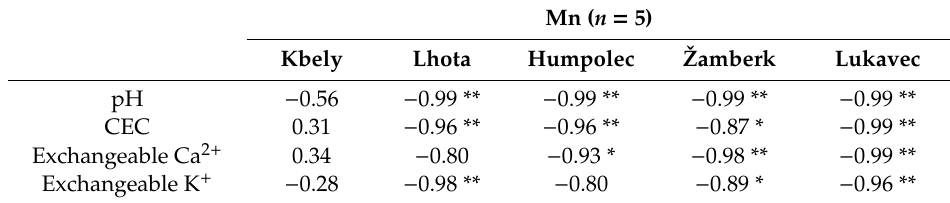
Ca 2 + and K + after addition of four levels of biochar (0.5%, 2%, 4%, and 8%) at the 12th week of incubation.